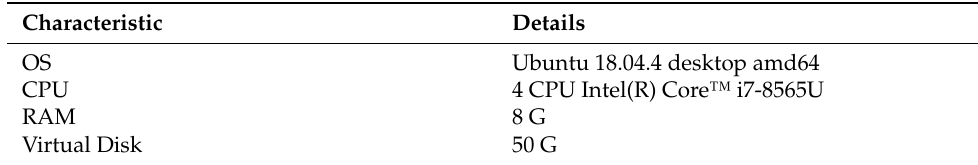
Table 3. Test VM characteristics.